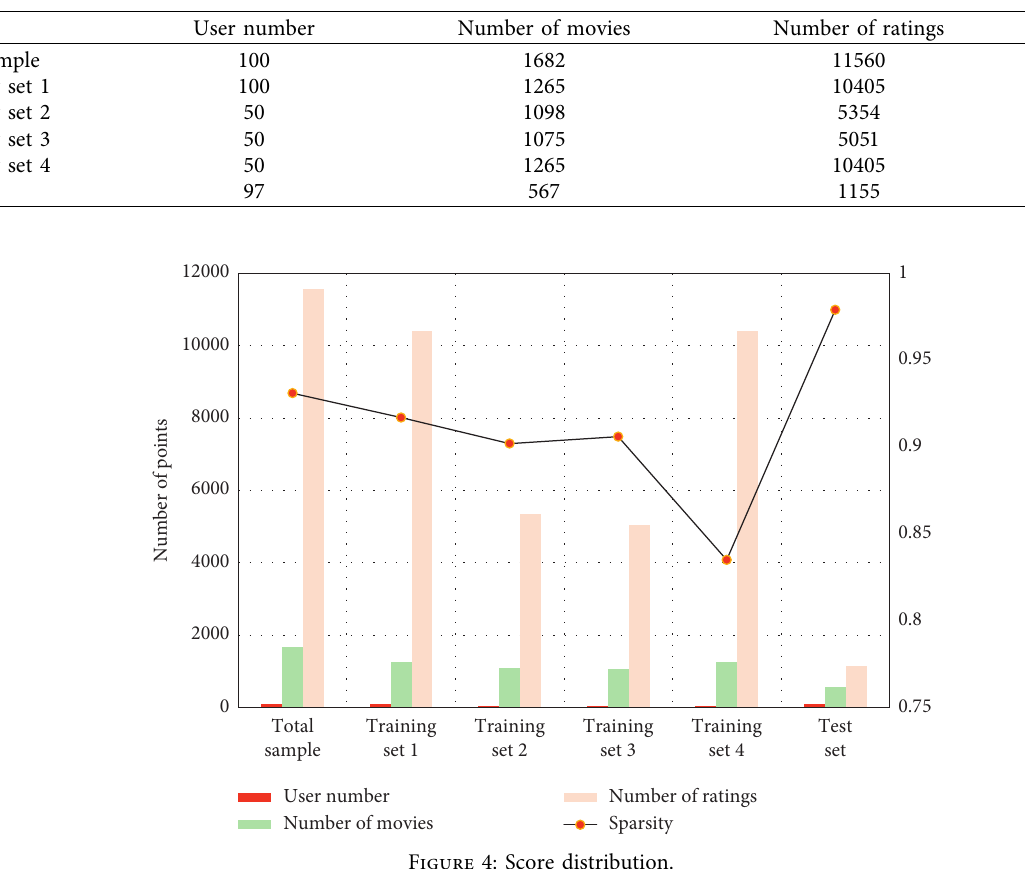
Table 1: Experimental data set.